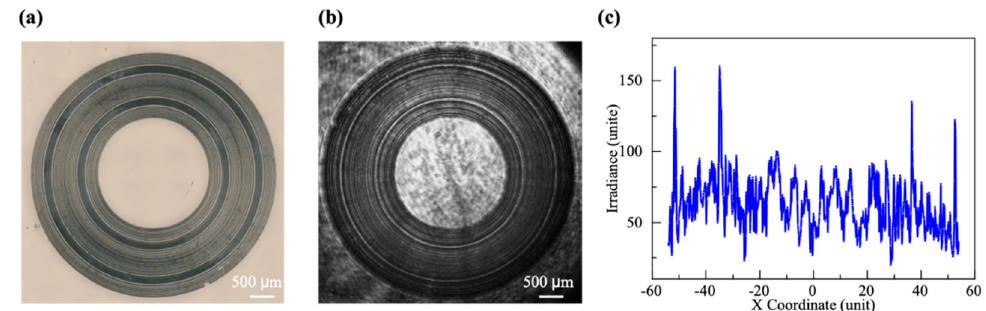
Figure 12. ( a ) The double-ring AFZP with R 1 = 1.60 mm and R 2 = 2.33 mm was fabricated using a femtosecond laser on a fused silica sample; ( b ) focusing double-ring behind the AFZP captured by a CCD; ( c ) energy distribution diagram of the focal plane.